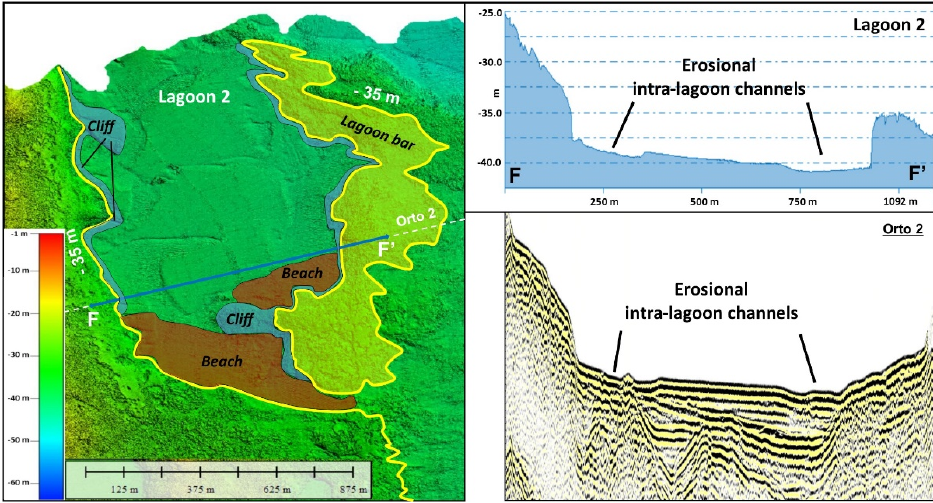
Figure 9. Location of Lagoon 2 (L2) within the northern sector of the study area and the comparison between bathymetric profiles (F–F (cid:48) ) and the seismic profile (Orto 2). The central portion of L2 shows the small morphological plateau and the lateral erosional intra-lagoon